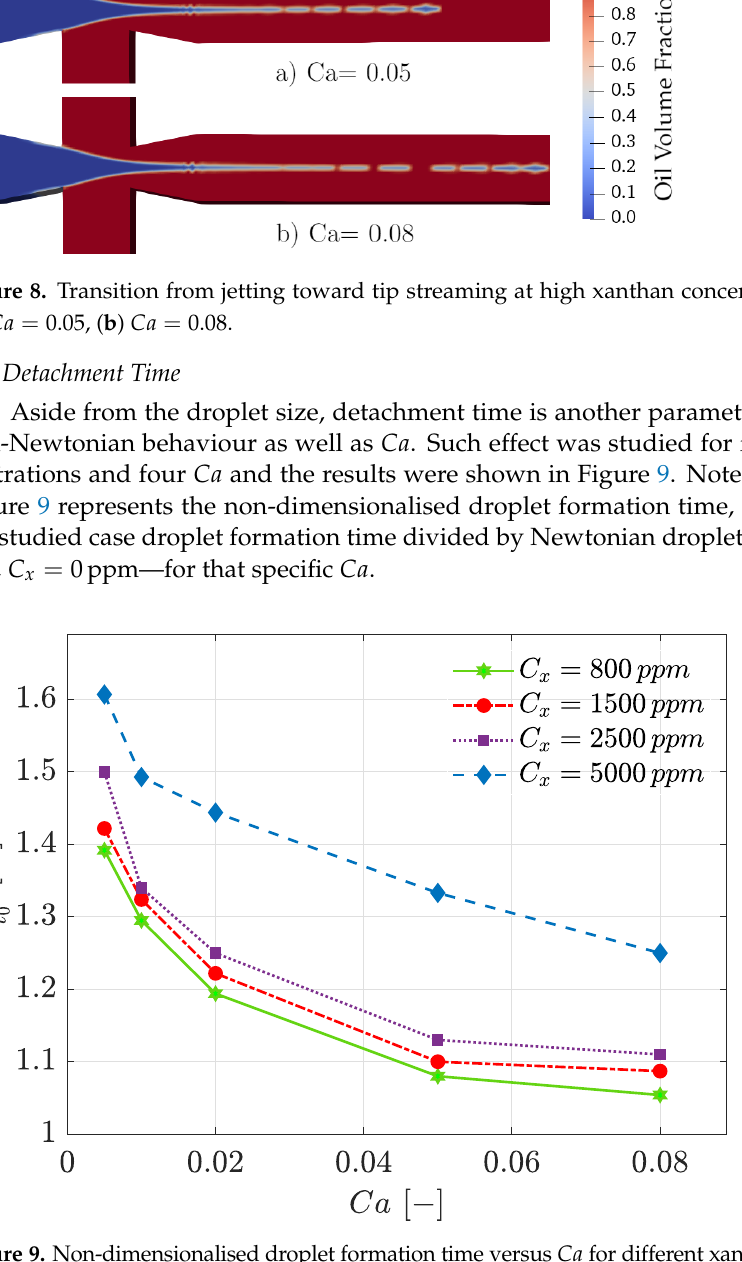
Figure 9. Non-dimensionalised droplet formation time versus Ca for different xanthan